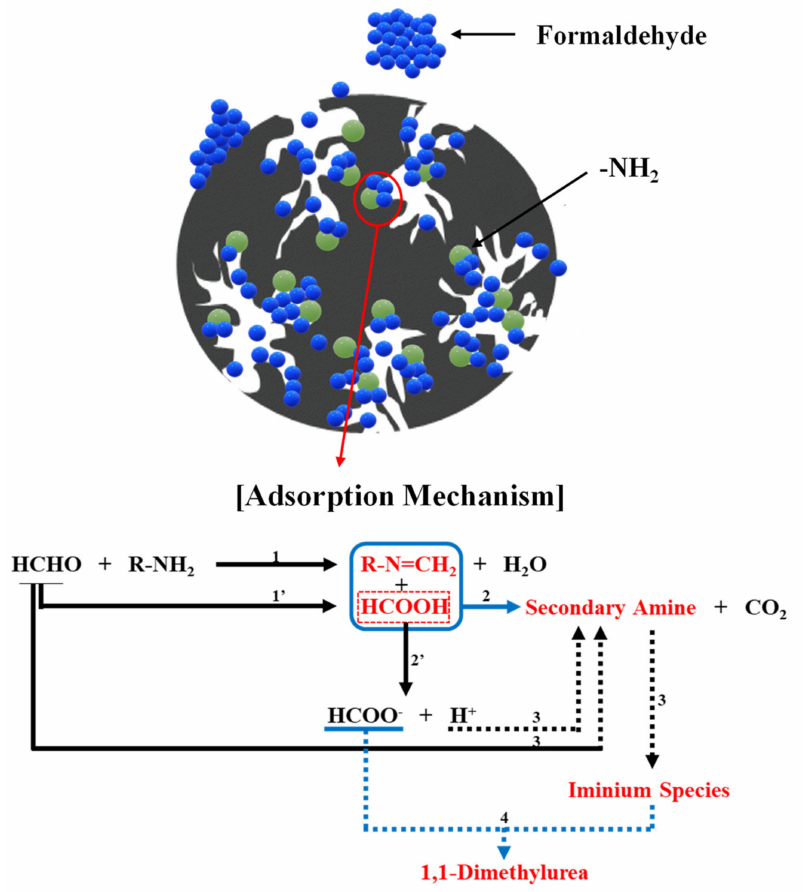
Table 4. Interaction states of amine chemicals after amination treatment of activated carbon and their applications.